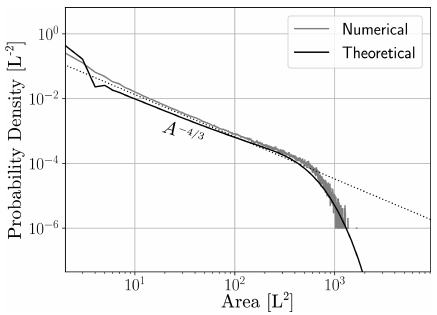
Figure 8. Probability density function of total contributing area on a hillslope with length L h = 100. The dashed line is A − 4 / 3